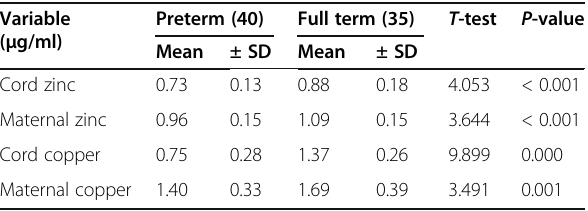
Table 1 Comparison between serum zinc and copper levels in cord and maternal blood of preterm and full-term neonates Variable Preterm (40) Full term (35) T -test P ( μ g/ml)